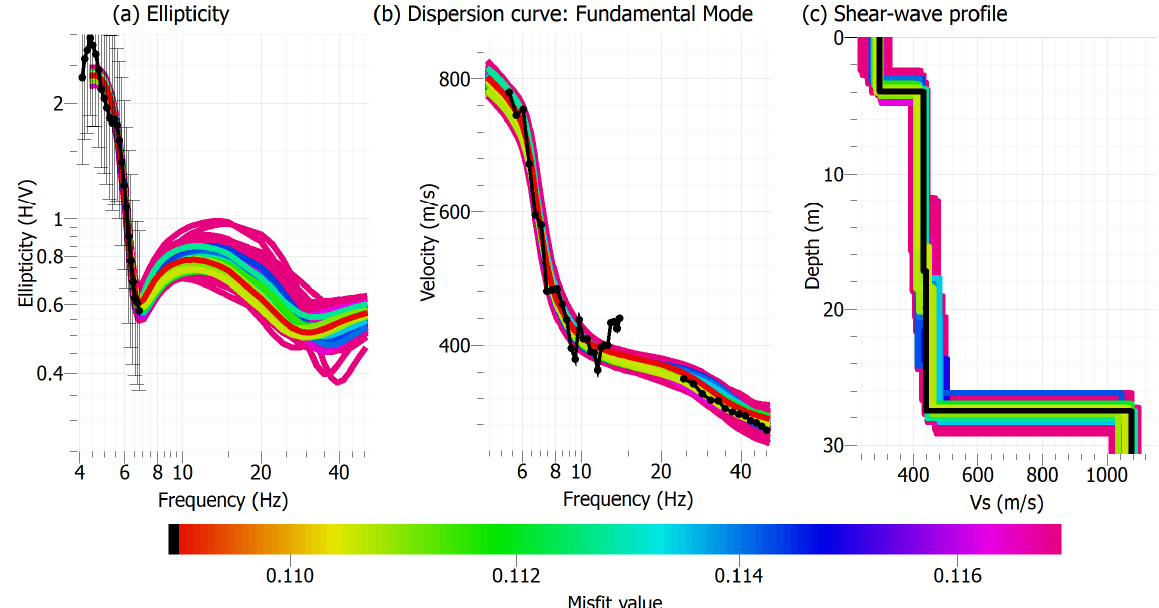
Figure 14. Inversion results in a point in Iquique using ellipticity of the Rayleigh waves from the H/V curve. ( a ) adjustment of the ellipticity curve between the observed curve (black line) and the best models. ( b ) adjustment of the dispersion curve between the observed curve (black line) and the best models. ( c ) models obtained from the inversion. Black line corresponds to the best model.